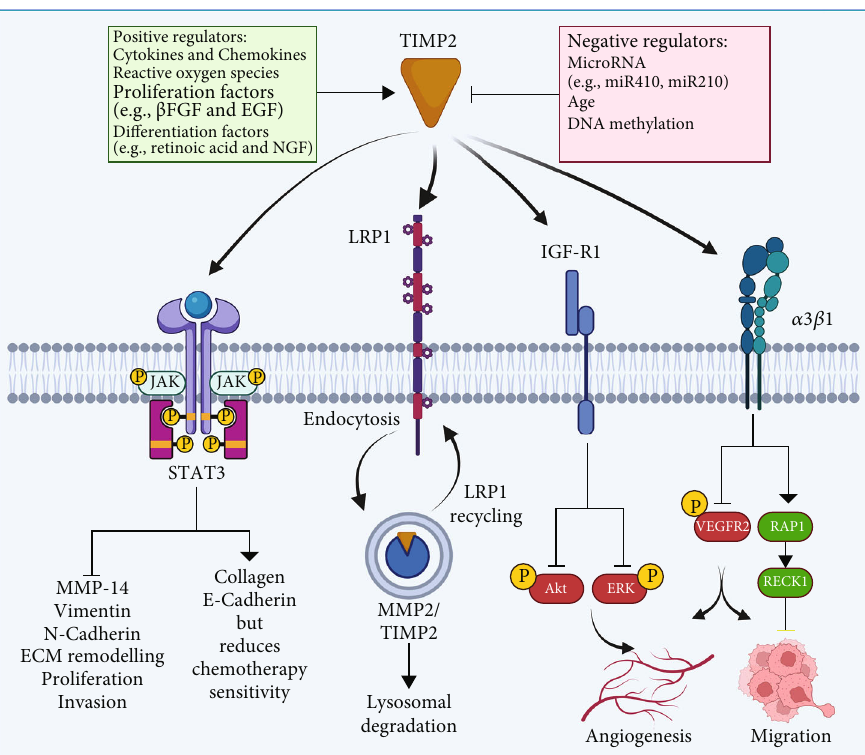
Figure 2: TIMP2 interacts with transcription factors and cell surface receptors. TIMP2 directly interacts with signaling molecules and transcription factors such as STAT-3, as well as cell surface receptors including α 3 β 1 integrin, IGF1R, and LRP1 to alter signaling transduction — created with